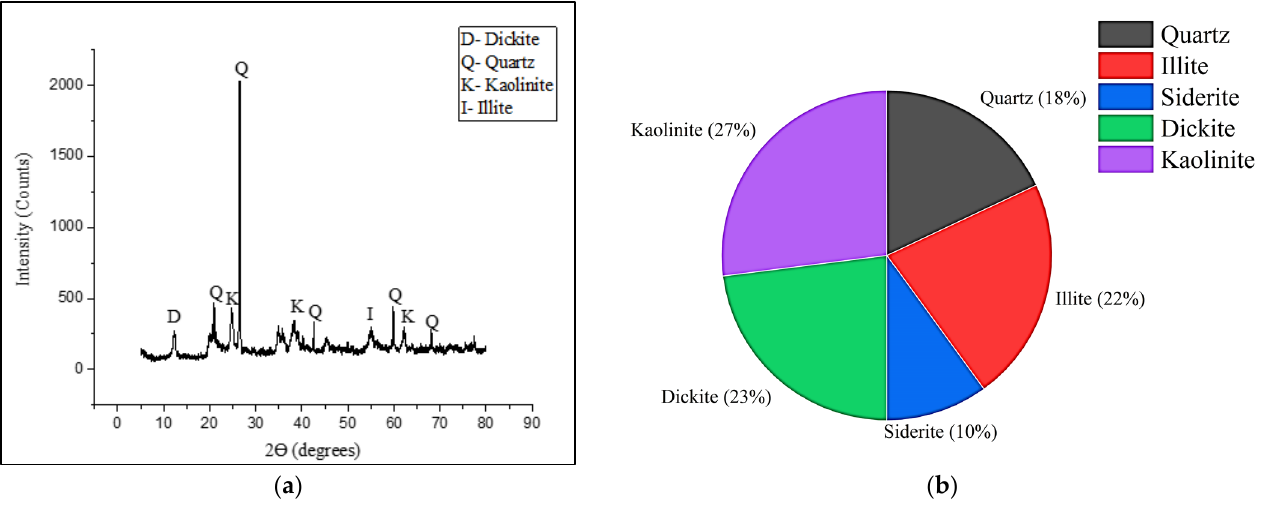
Figure 12. Characterization of minerals and compounds. ( a ) XRD analysis of Brahmavar sample, ( b ) quanti fi cation of compounds.